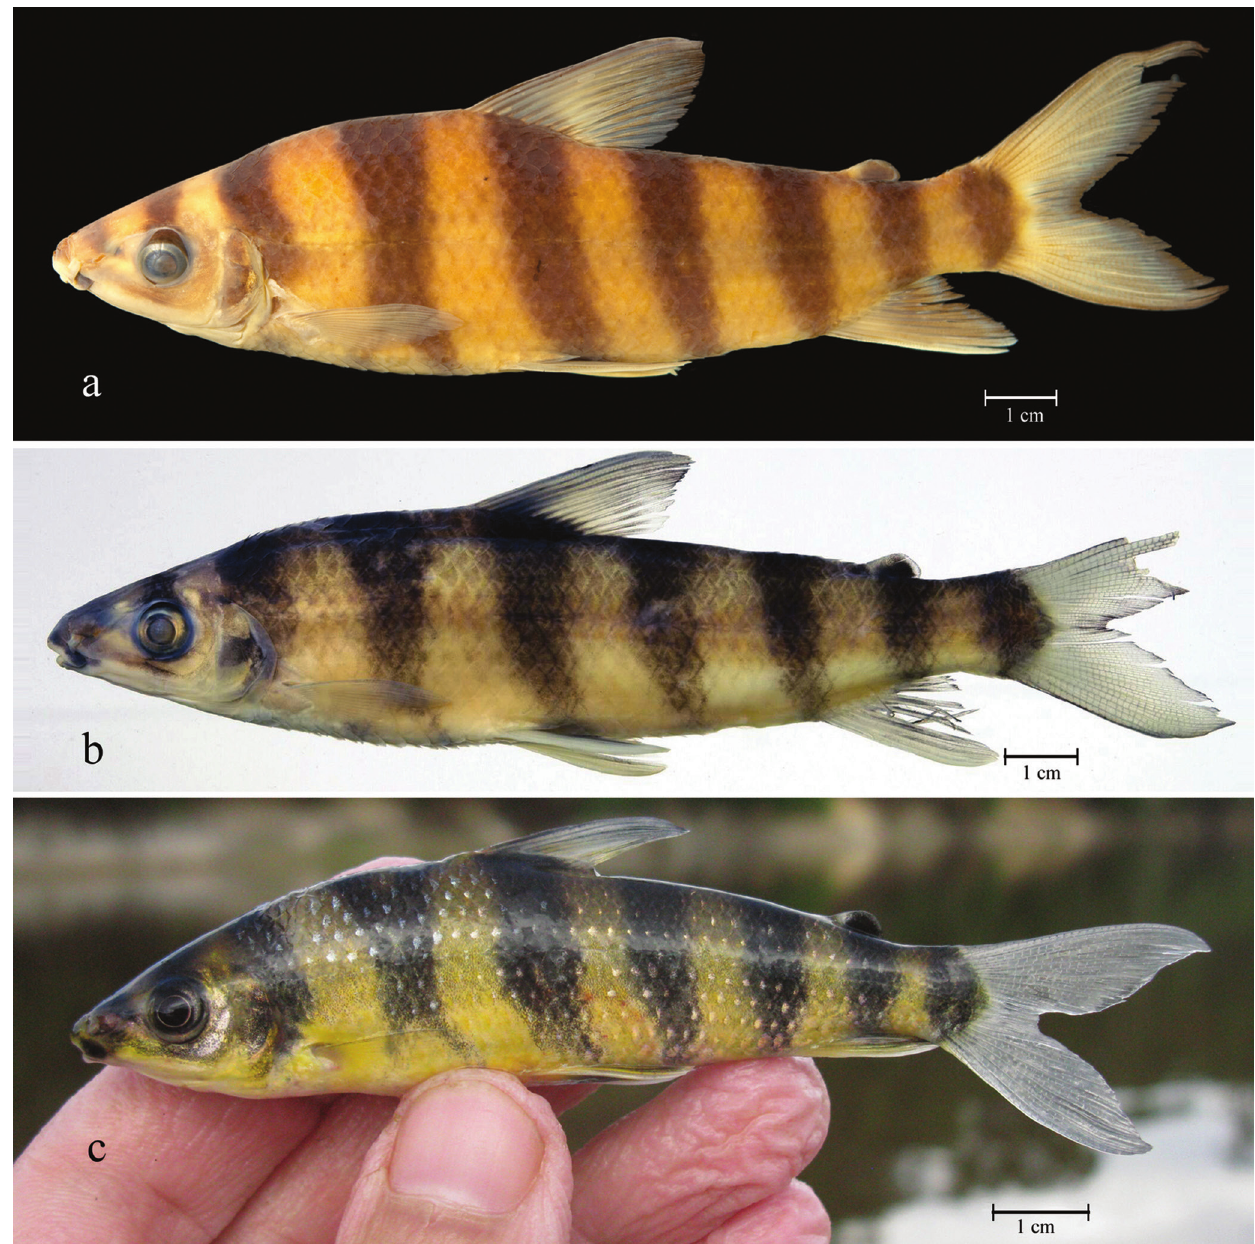
Fig. 10. Leporinus enyae : (a) holotype, MCNG 56681, 1, 145.5 mm SL, río Iquapo, Orinoco basin in Venezuela, alcohol-preserved, (b) INPA 43068, 137.6 mm SL, rio Negro at Cachoeira Bububri, São Gabriel, alcohol-preserved, photographed by Douglas Bastos, (c) paratype, AUM 53793, 80.3 mm SL, río Caura, Orinoco basin in Venezuela, photographed live by José